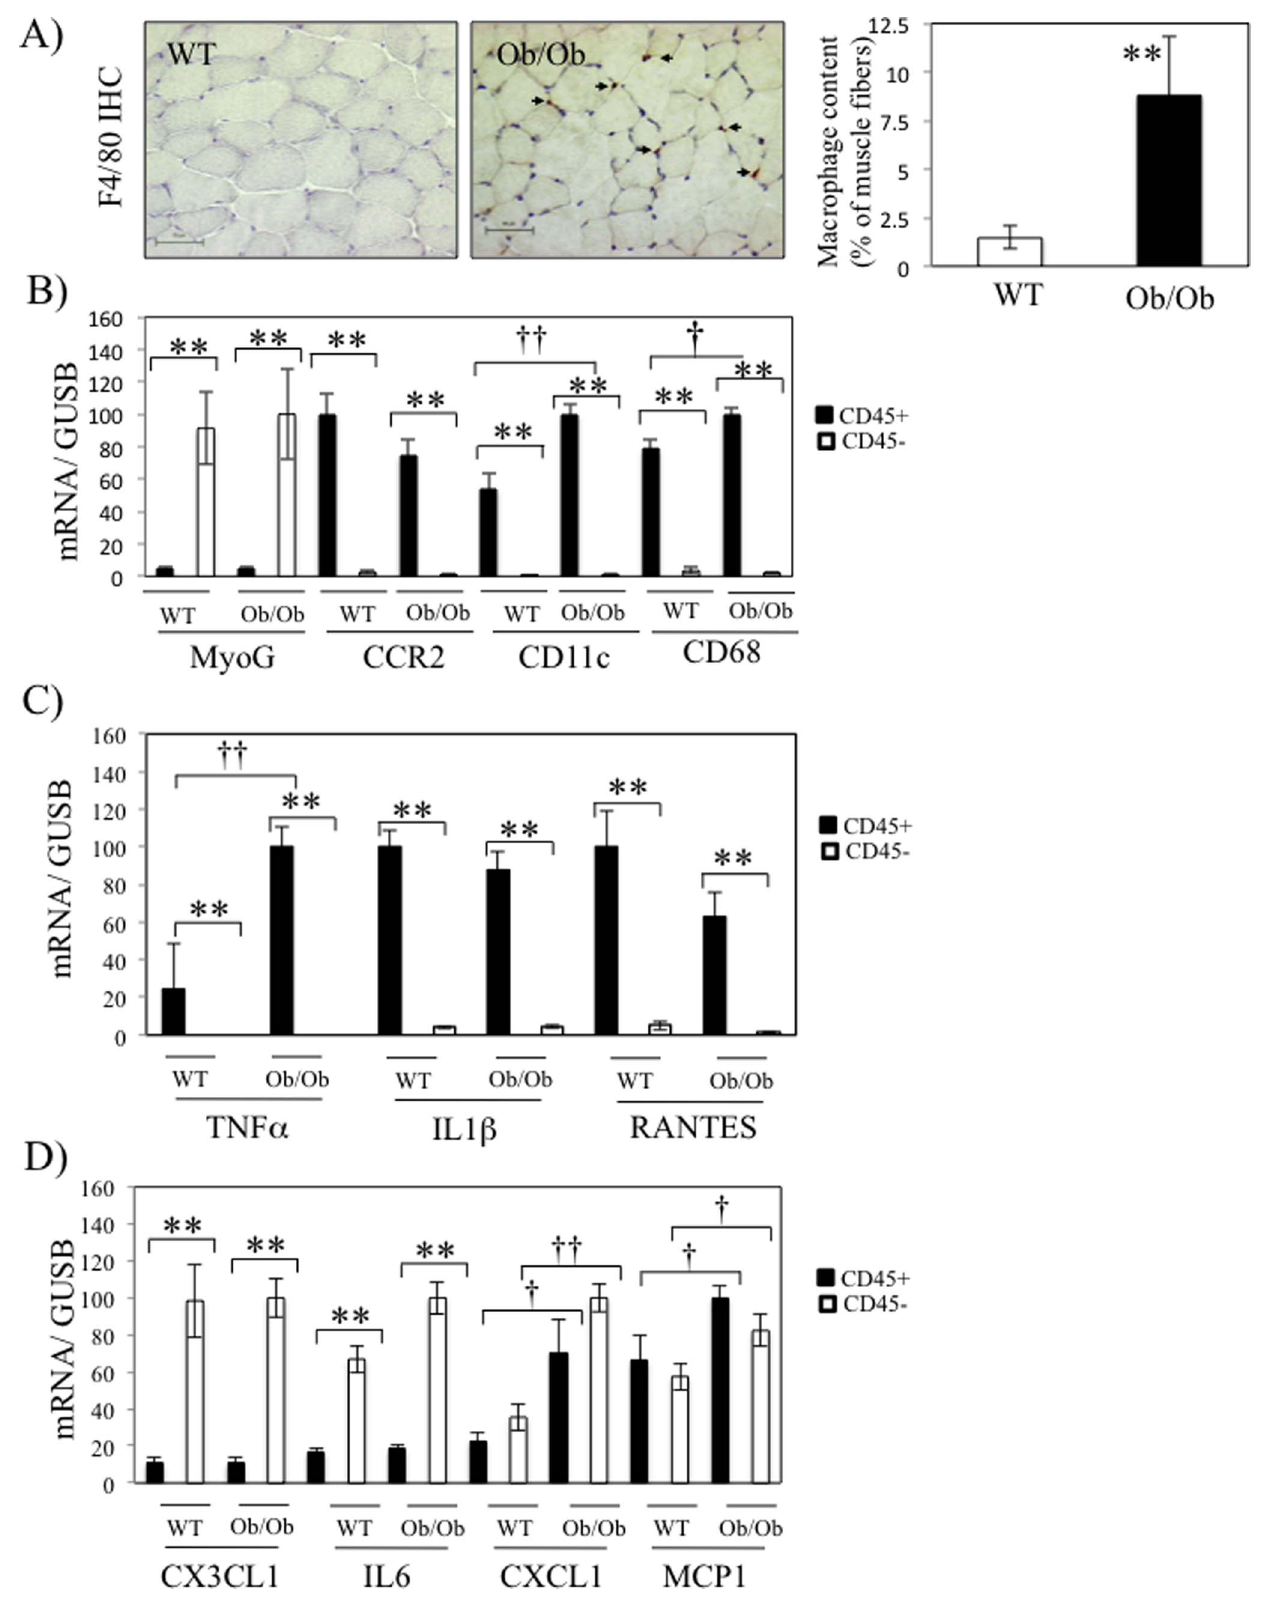
Figure 2. Macrophage recruitment in skeletal muscle of ob/ob mice. A) Representative images (left panel) and quantitative analysis (right panel) of the immunostaining with F4/80 antibody in gastrocnemius of wild-type (wt) and ob/ob mice. B–D) Following digestion of skeletal muscles (gastrocnemius and quadriceps), CD45 + and CD45- cells were purified and qPCR were performed on the indicated genes in wt and ob/ob mice. The